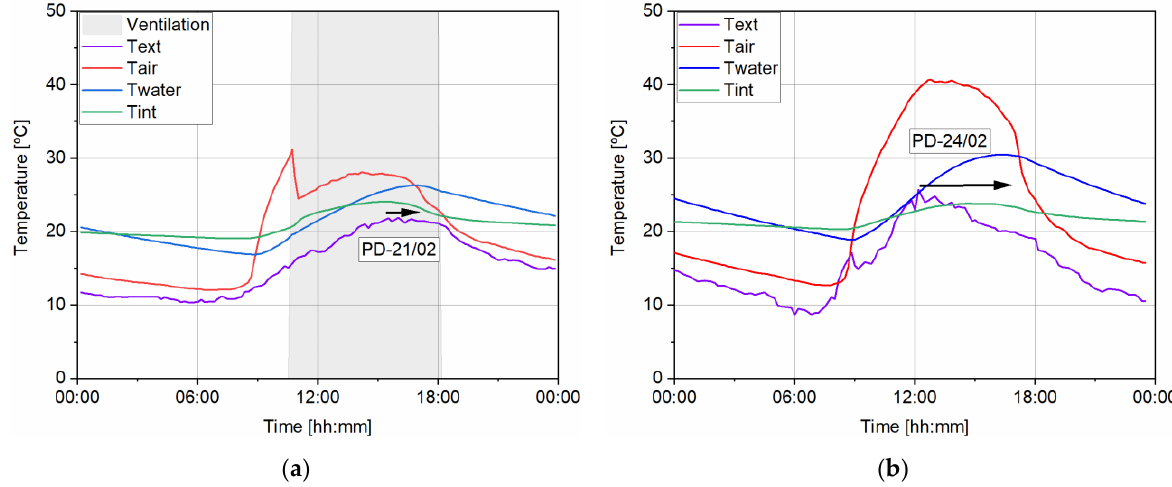
Figure 8. BIPV-WS layer temperature evolution: ( a ) February 21st, ventilated air cavity; ( b ) February 24th, non-ventilated air